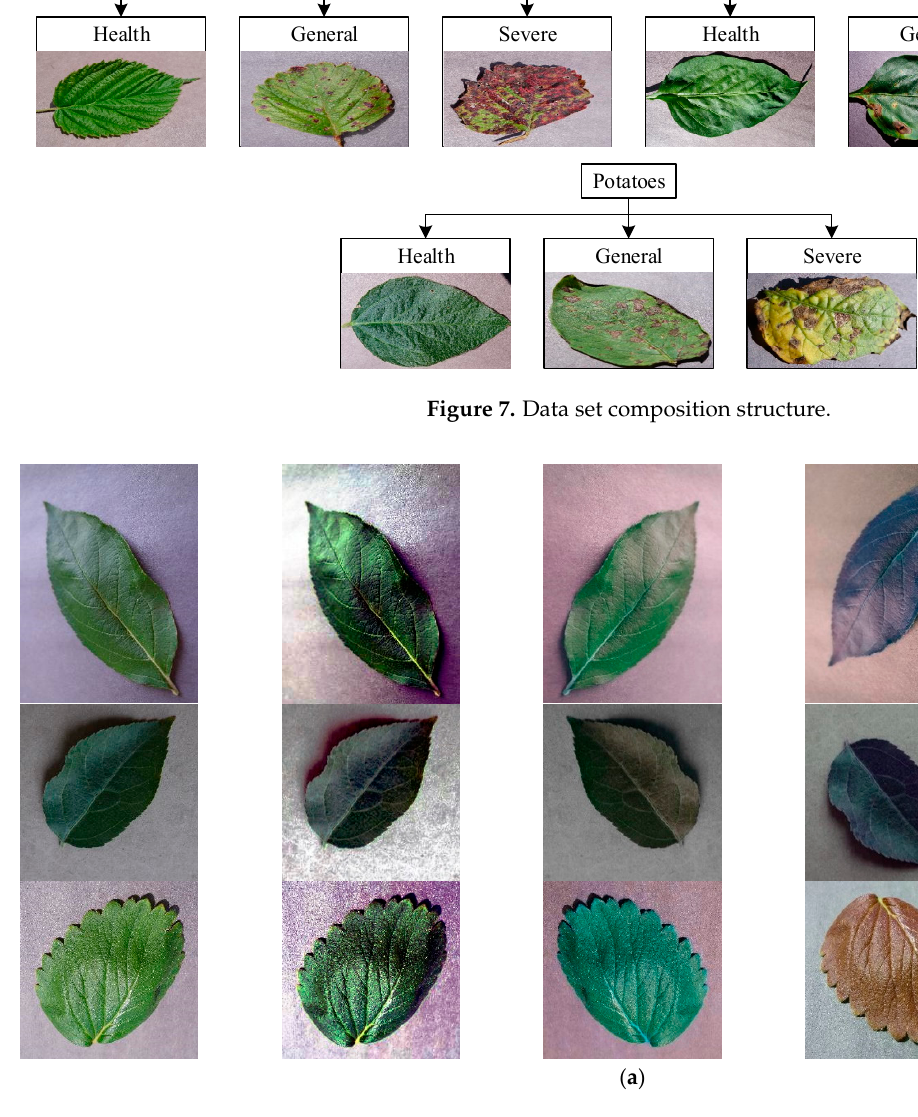
Figure 7. Data set composition structure.